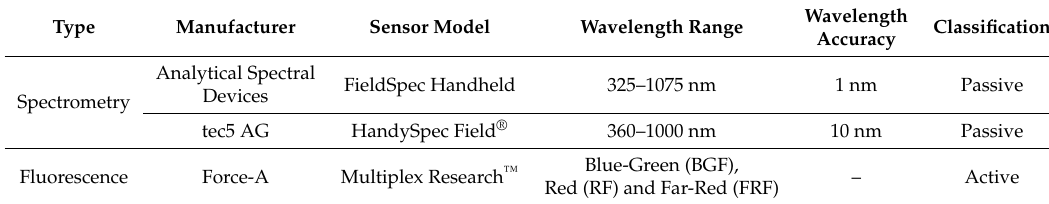
Table 1. Used sensor devices and sensor